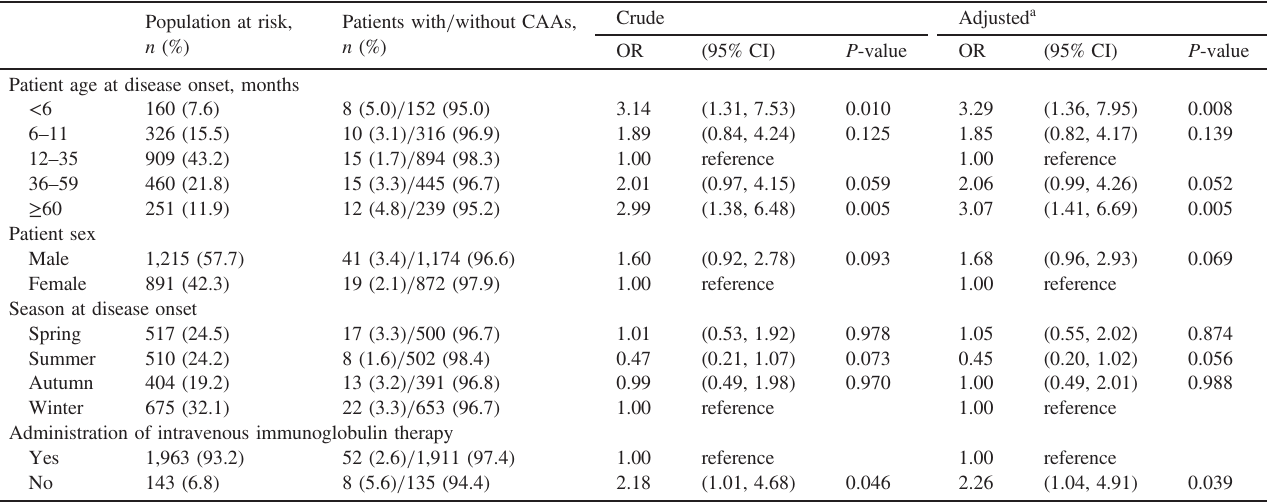
Table 4. Odds ratios of patient age and sex for developing coronary artery abnormalities (CAAs) at 1 month after the onset of Kawasaki disease ( n = 2,106) Age, months